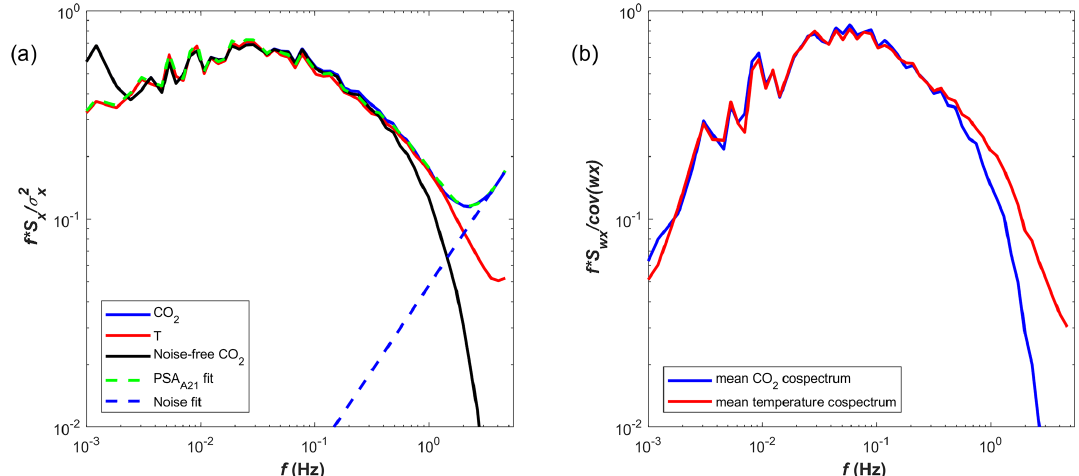
Figure 11. (a) Power spectra of (1) sonic temperature (red), (2) CO 2 from the Siikaneva site measured simultaneously with D 1 (black), and (3) noise-removed CO 2 (dashed blue); shaded areas show the frequency range used for noise fitting for PSA I07 , and time constant fitting for PSA I07 and PSA A21 . (b) Cospectra of CO 2 (black) and T (red) with vertical wind speed ( w ). Table 2. Time constants obtained via different approaches (PSA I07 , PSA A21 , and CSA √ relevant statistics. Method PSA I07 PSA A21 CSA √ τ (s) 0.095 0.075 0.173 Coefficient of determination ( R 2 ) of time constant fitting 0.989 0.993 0.958 Coefficient of determination ( R 2 ) of noise fitting 0.99 Slope of noise fitting 0.82 Frequency range of noise fitting (Hz) Frequency range of time constant fitting (Hz) Normalization factor ( F n